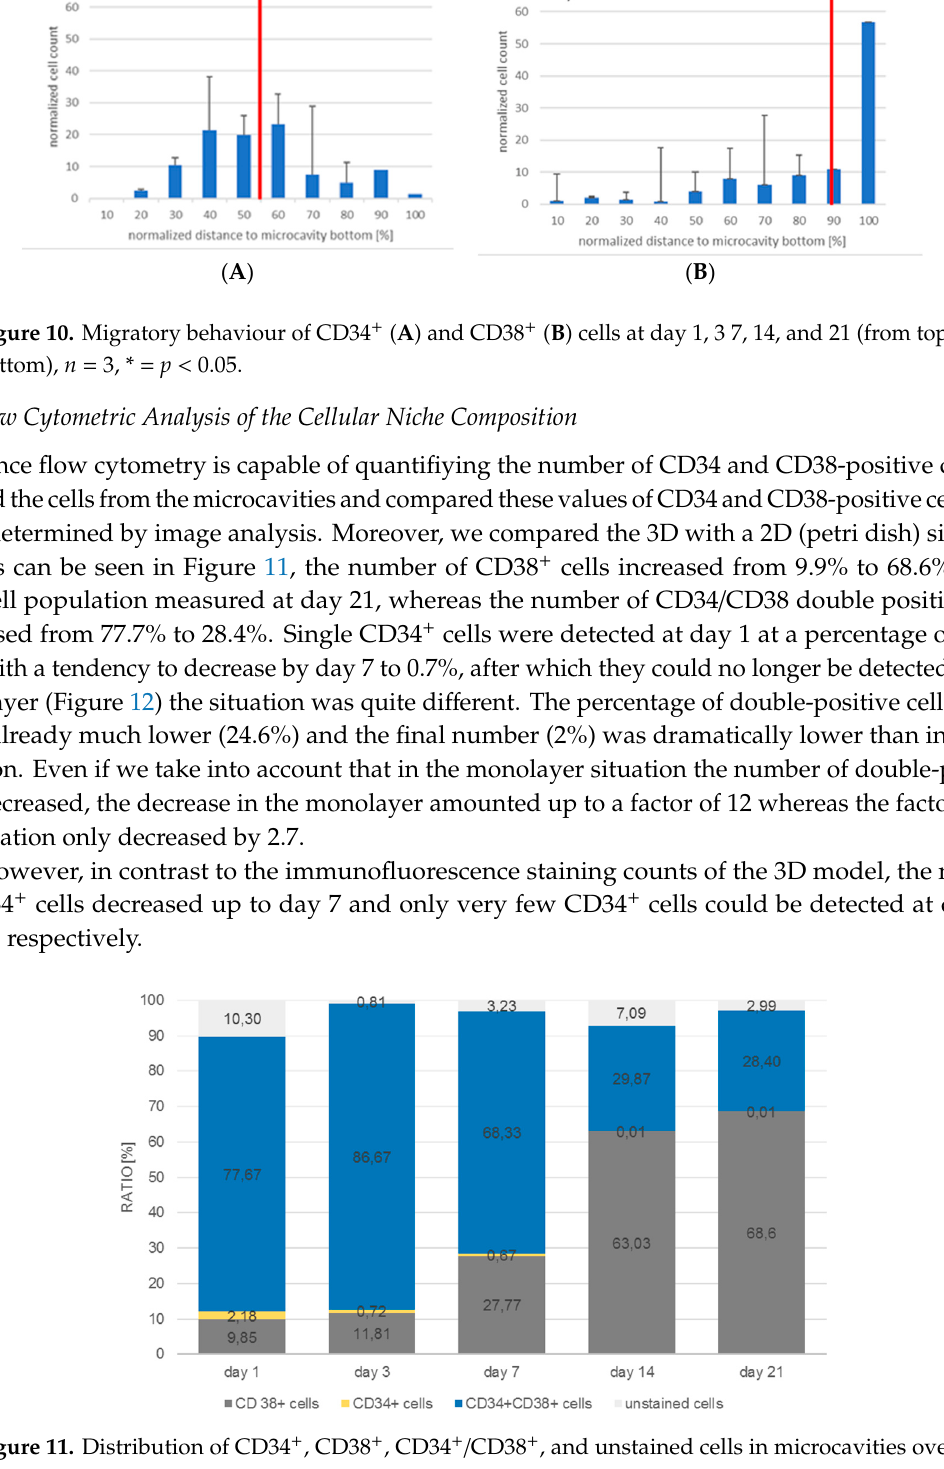
Figure 12. Distribution of CD34 + , CD38 + , CD34 + /CD38 + , and unstained cells in monolayer over a period of 21 days.